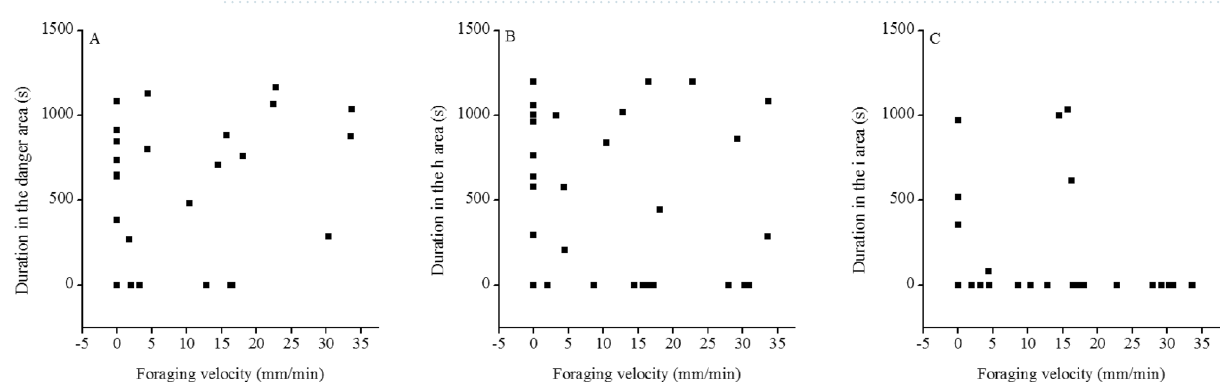
Figure 2. Experiment 2: duration in the danger area ( A ) and in the escape area ( B ) in Mesocentrotus nudus (fasted for 7, 14 and 21 days) exposed to conspecific alarm cues.